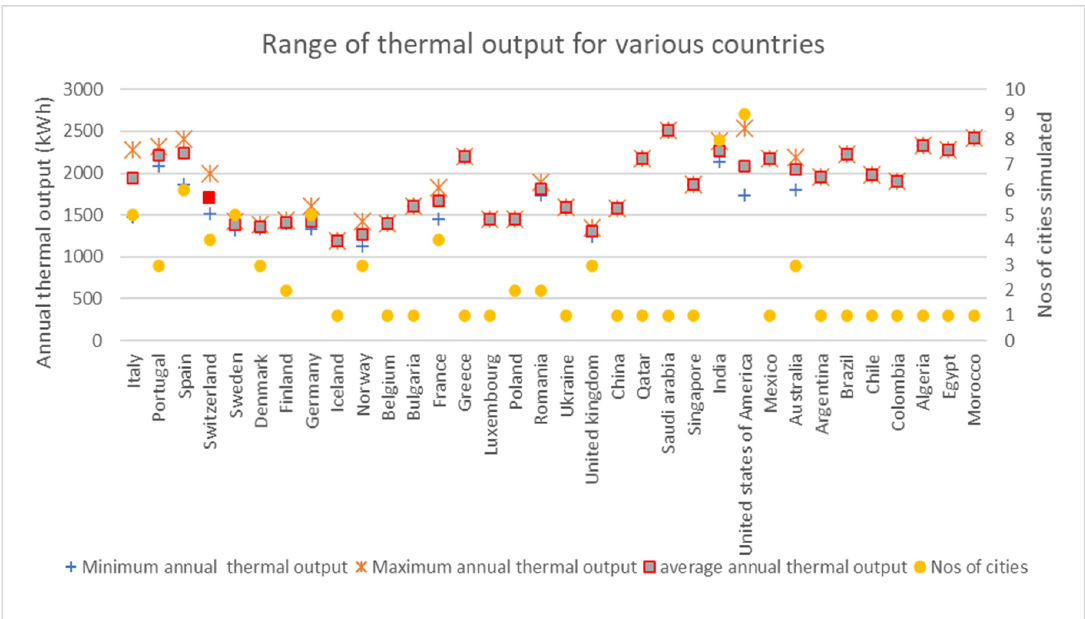
Figure 11. Country-wise collector thermal performance uncertainty.